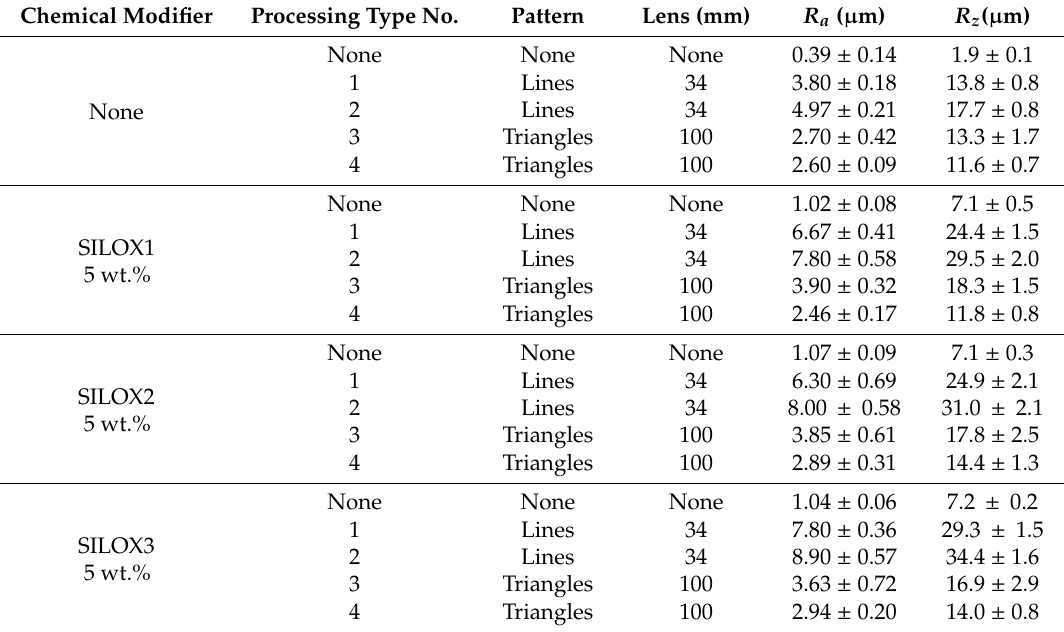
Table 3. Roughness parameter values for samples before and after laser